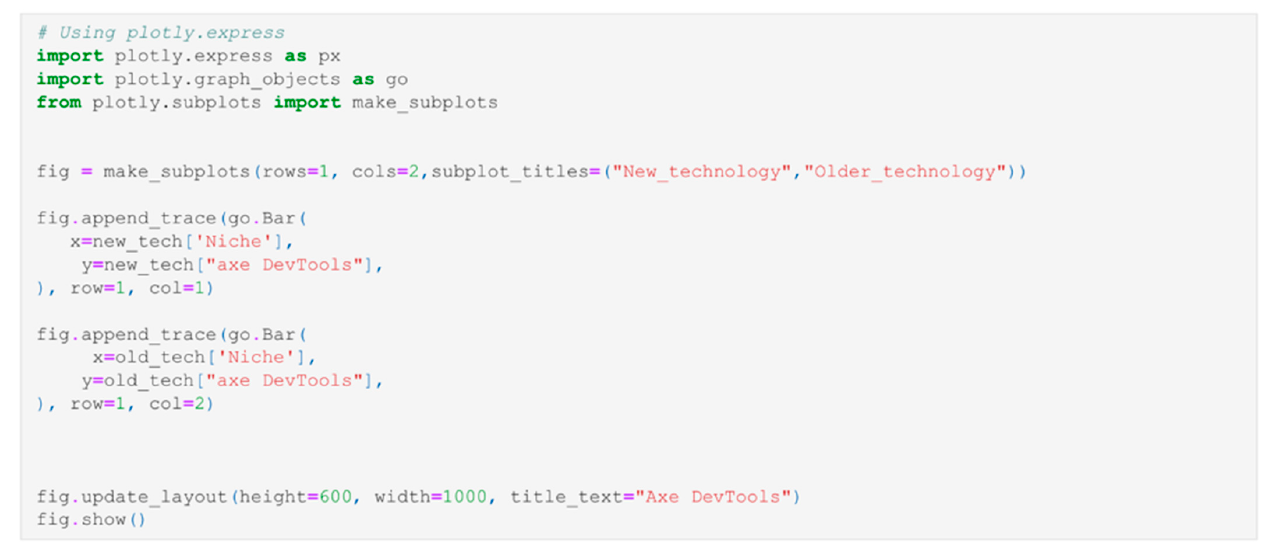
Figure 9. PWA vs. non-PWA industry plots—Axe DevTools (T7).